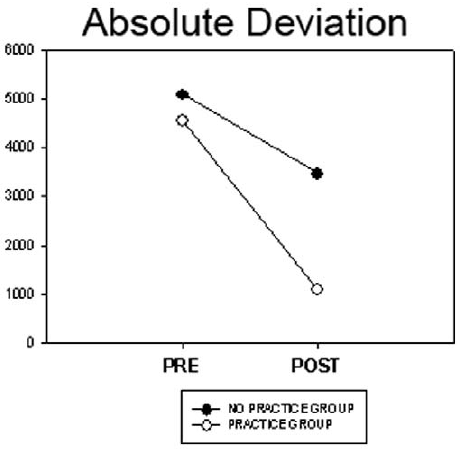
Figure 6. Two-factor interaction of absolute deviation for Day and Group. On day of post-test, the group with four days of practice performed significantly better than the group with no practice.